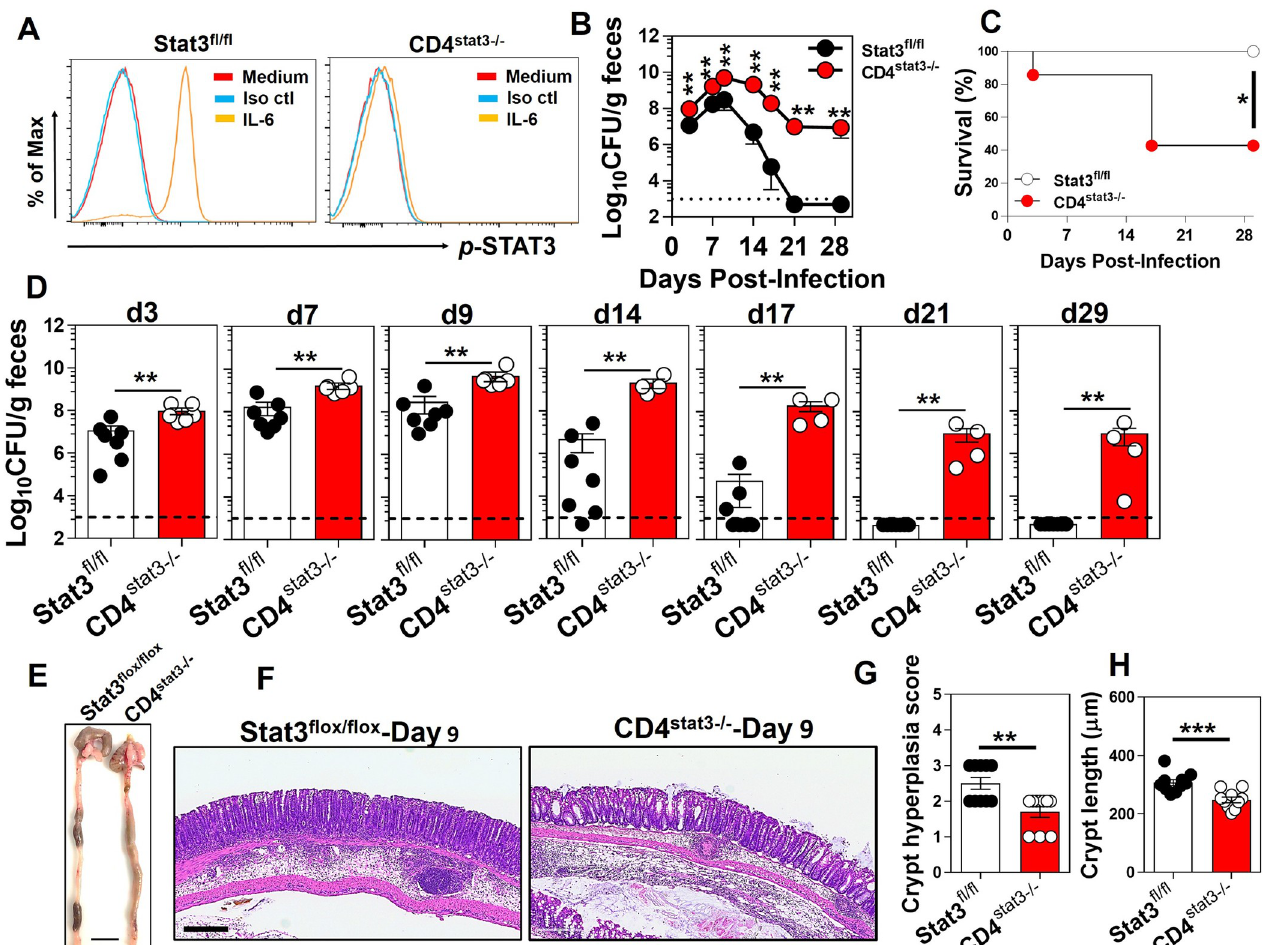
Fig 6. Lack of STAT3 signaling in CD4 + T cells renders the host susceptible to enteric infection. A . IL-6 stimulation (20 ng/ml) of splenocytes from CD4 stat3-/- mice did not induce the phosphorylation of STAT3 protein, indicating the complete abrogation of the STAT3 signaling in the conditional KO CD4 + T cells. B . Infection kinetics and D . bacterial burden in the feces of mice with conditional deletion of STAT3 in CD4 + T cells (CD4 stat3-/- ) and littermate controls (STAT3 flox/flox ) shown as colony forming unit (CFU)/g feces. The dashed line represents the sensitivity of the culture method. �� p < 0.01 determined by Mann-Whitney U test. C . CD4 stat3-/- mice exhibited increased susceptibility to colon infection upon inoculation with 5 × 10 8 CFU of C . rodentium . Survival is represented by Kaplan-Meier survival curves ( n = 4–7 mice/group). � p < 0.05. The results are the Mean ± SEM of 4–7 mice per group from one independent experiment. Mice with STAT3 selectively deleted in CD4 + T cells are contrasted with littermate mice with a floxed STAT3 gene but without the Cre gene to delete the floxed gene. E. Representative images of gross pathology in the colon of CD4 stat3-/- mice and Stat3 flox/flox mice infected with C . rodentium for 9 days. The scale bar, 1 cm. F. Representative images of microscopic pathology in the distal colon of CD4 stat3-/- mice and STAT3 flox/flox controls 9 days after infection with C . rodentium , as assessed by hematoxylin and eosin (H&E) staining (5 × ). The scale bar, 300 μ m. G, H . Crypt hyperplasia scores and crypt length ( μ m) in the distal colon of CD4 stat3-/- mice and STAT3 flox/flox controls at 9 days after infection with C . rodentium . Data are the Mean ± SEM from two pooled independent experiments using CD4 stat3-/- ( n = 10) or STAT3 flox/flox ( n = 10) mice. � p < 0.05 determined by Mann-Whitney U test.